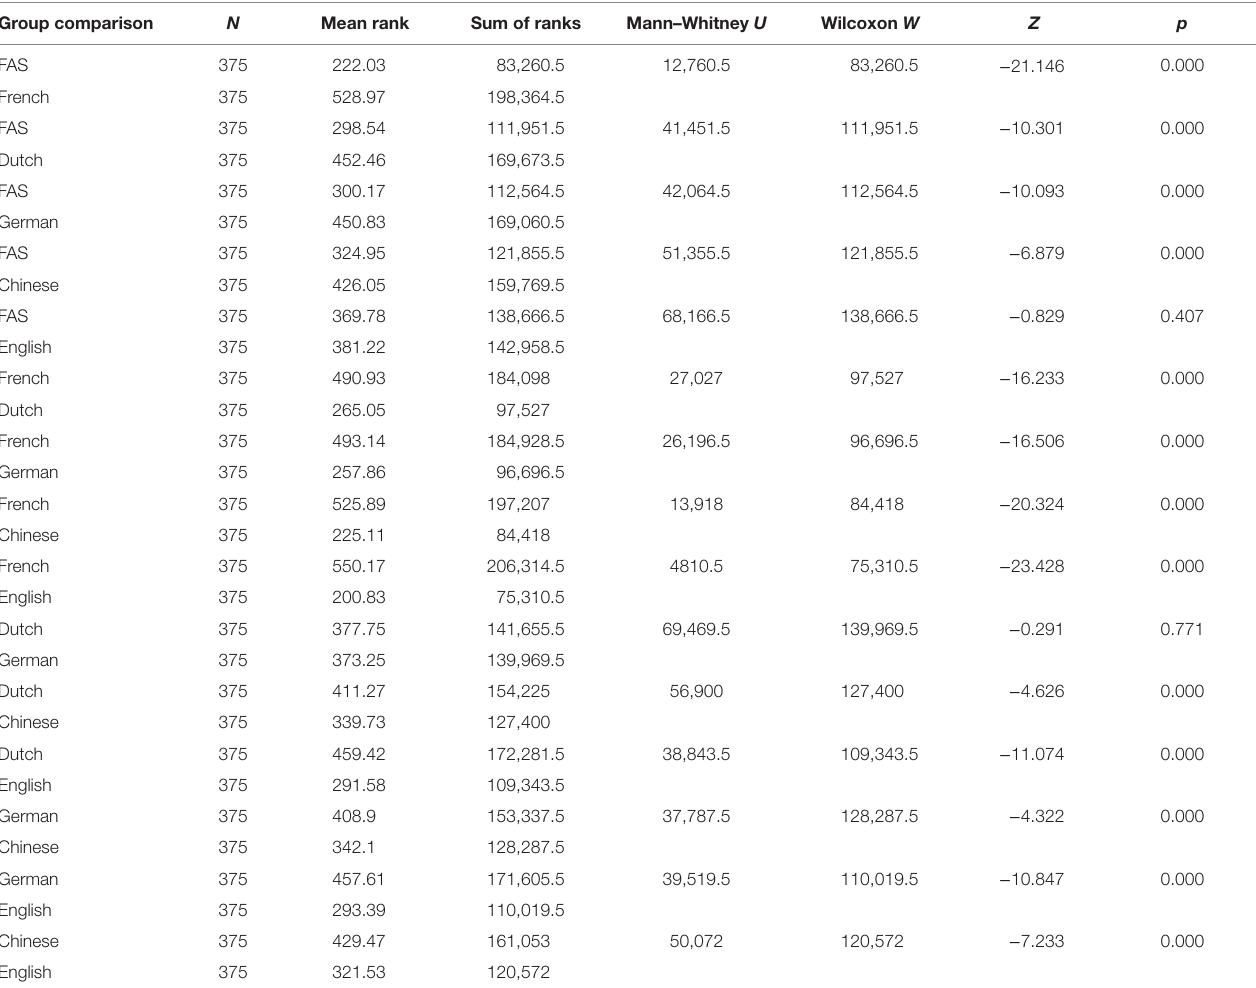
taBLe 7 | perceptual accent rating experiment: Mann–Whitney U scores for the individual inter-speaker comparisons.